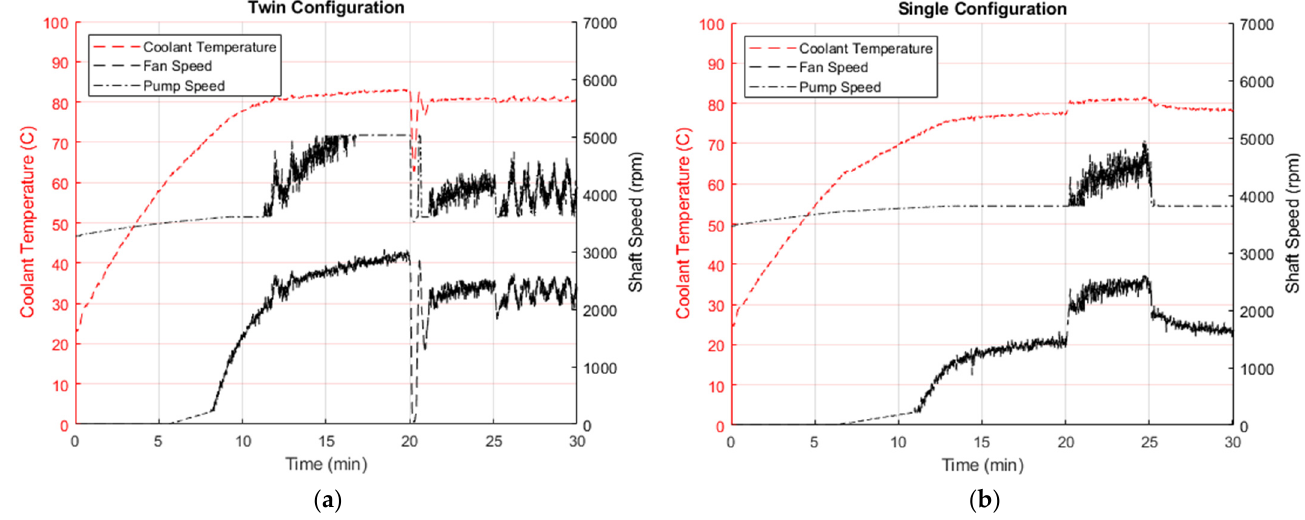
Figure 5. Coolant temperature (left axis) and fan/pump shaft speeds (right axis) with respect to time for ( a ) twin- and ( b ) single-radiator configurations.